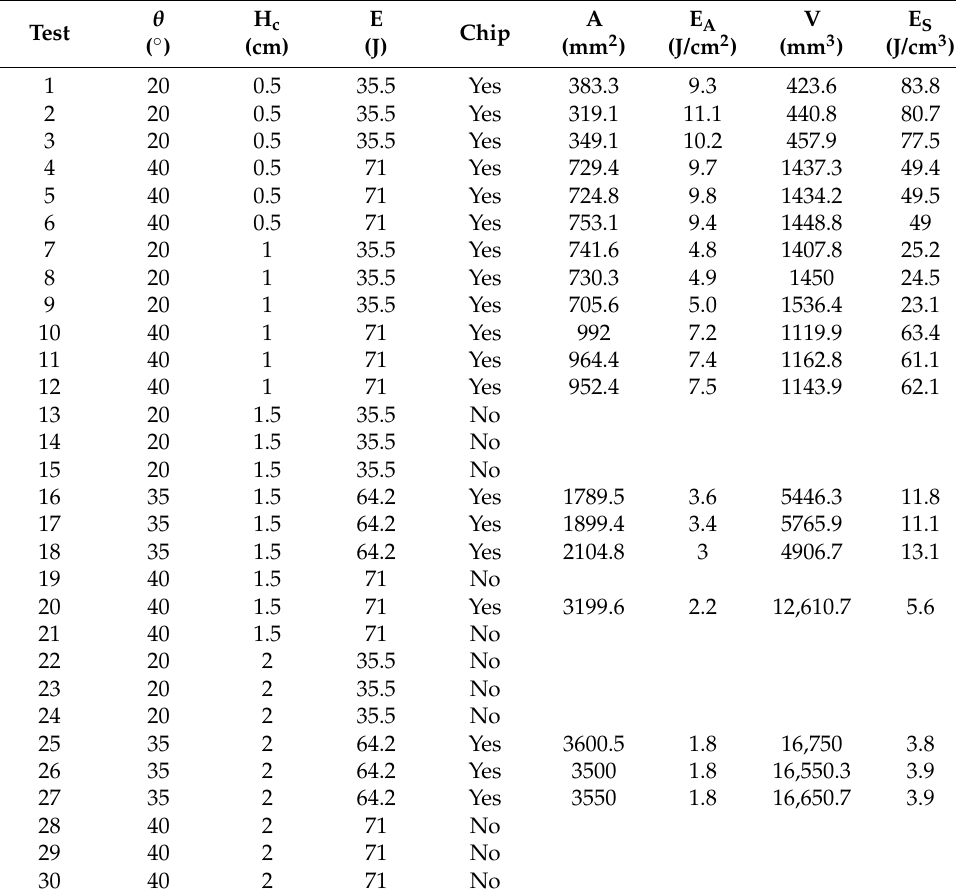
Table 2. Summary of tests on samples with a c/s ratio of 1:1. (The precision of the measures is of the order of 0.5 ◦ for θ and 0.1 cm for H C . Besides, the precision of the scanner 3D is 5 mm). θ Test ( ◦